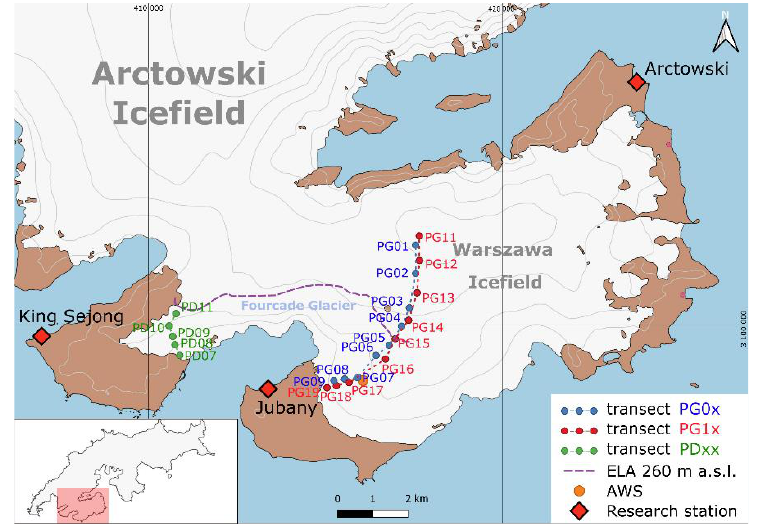
Figure 7. Map of the research area on KGI including the locations of the ELA and mass balance stake along two transects, PG0x and PG1x (where x is a placeholder for stake number) within the Fourcade Glacier catchment, modified from Falk et al. [17].